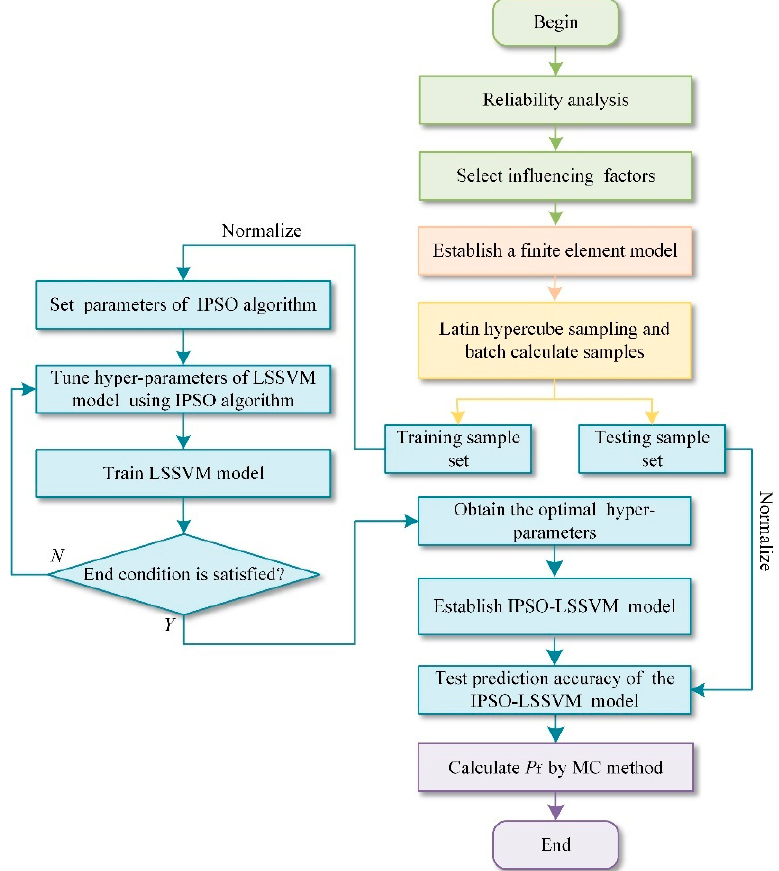
Figure 1. Flow chart of calculating the reliability of concrete gravity dams.